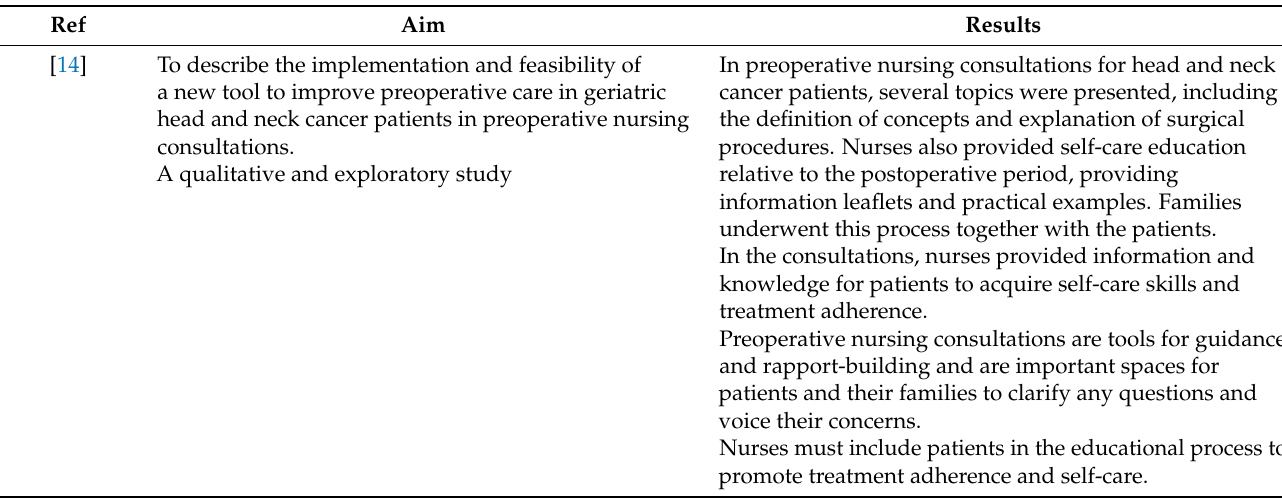
Table 4. Bibliographic sample.